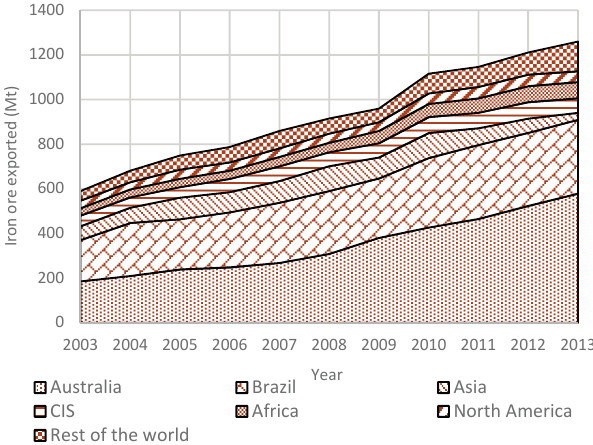
Figure 5. World iron ore exports split into major exporting regions